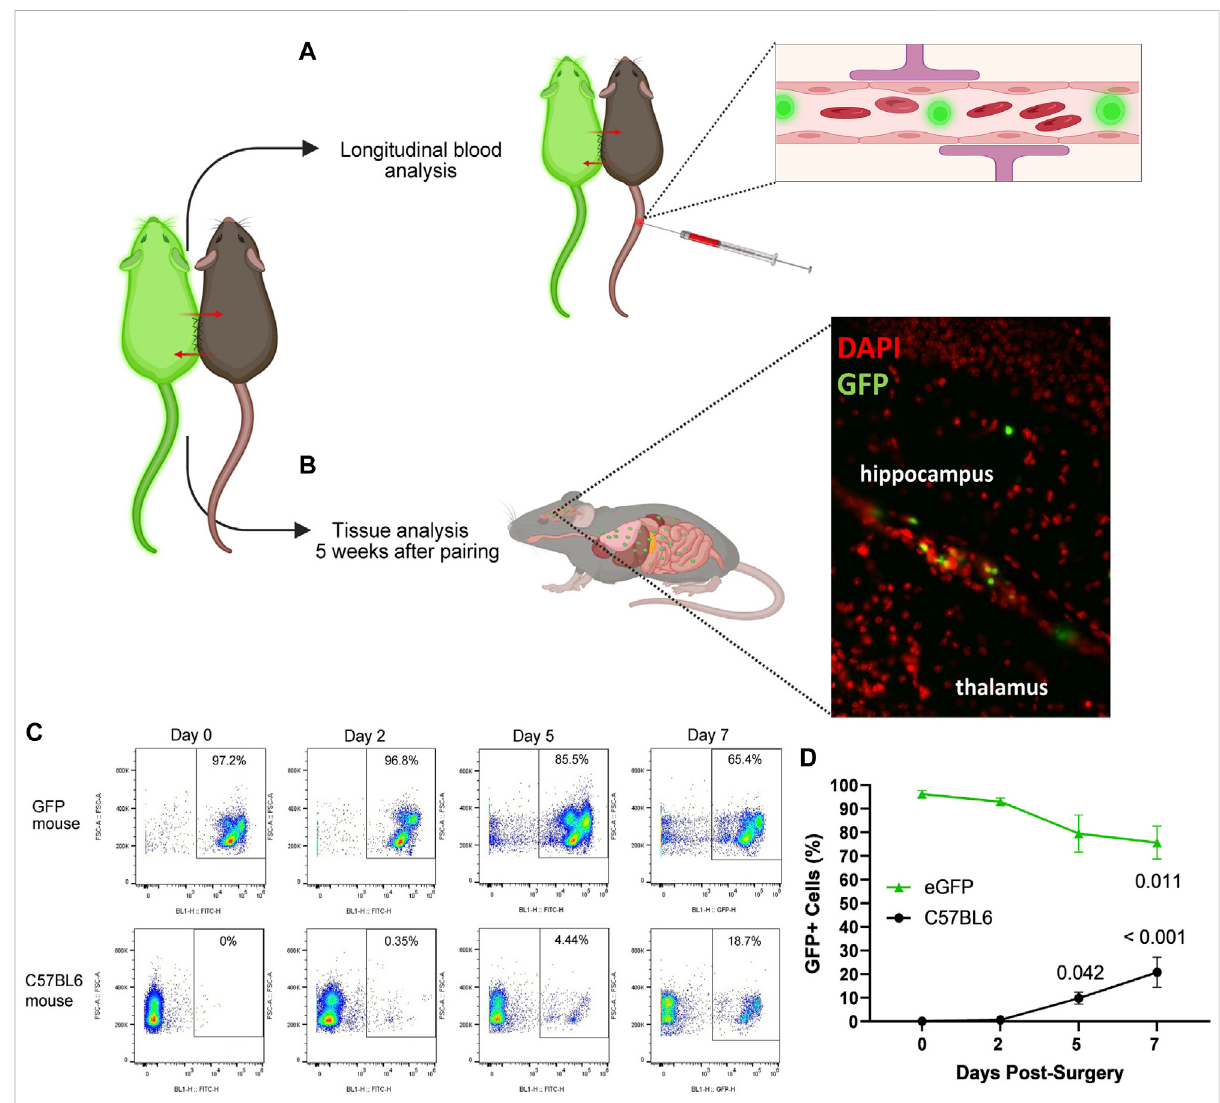
FIGURE 6 Strategiesforcon fi rmingbloodchimerismfollowingparabioticsurgery.Usingatransgenicmodelthatexpressesa fl uorescentreporterinblood cells, such as eGFP, and C57BL6 heterogenic pairs, circulatory exchange can be con fi rmed by (A,C,D) longitudinal blood analysis and/or (B) tissue analysis after5weeksofpairing,demonstratingGFP+cellsinthebrainofaC57BL6parabiontusing fl uorescentmicroscopy. (C) Representative fl ow cytometry in eGFP (top row) and C57BL6 (bottom row) heterogenic parabionts at 0, 2, 5, and 7 days postoperatively. (D) Abundance of GFP + cellsinbloodcirculationineGFP(greentriangles)andC57BL6(black circles)heterogenicparabionts,withconclusivebloodexchangeasearlyasday 5. (Friedman test with multiple comparisons, compared to day 0. Mean ± SEM, n = 6 mice per